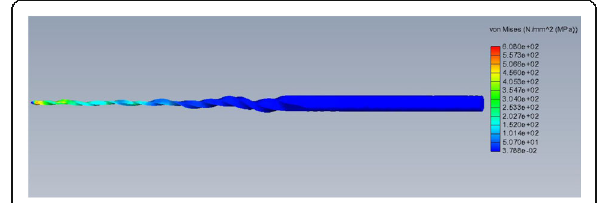
Fig. 7 Stress distribution during torsion test of ProTaper NEXT